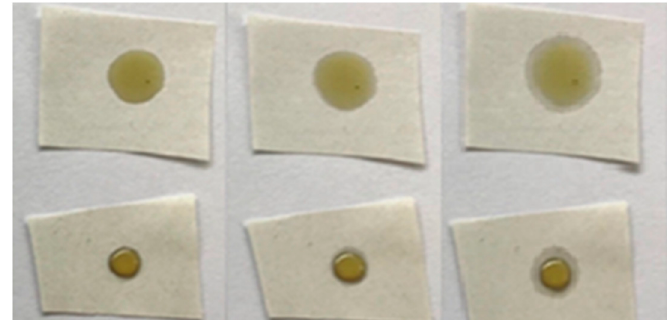
Figure 4. Time lapse of untreated ( above ) and industrial-plasma treated ( below ) paper 1, from left to right, immediately after plasma treatment, 10 min after plasma treatment, and 24 h after plasma treatment.